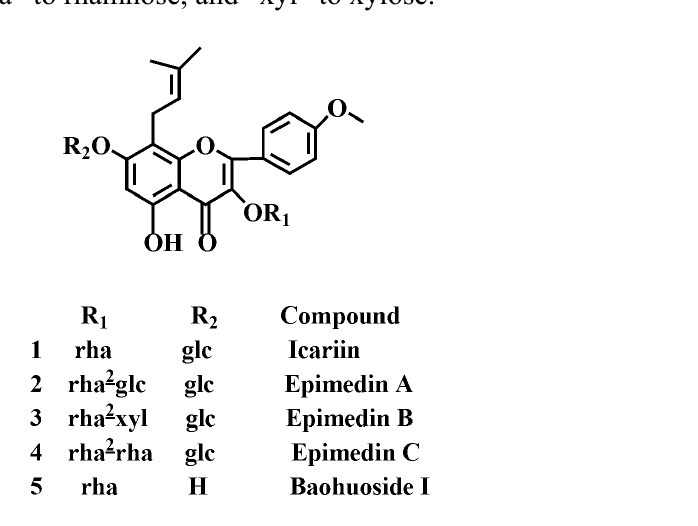
Figure 1. Chemical structures of five prenylated flavonoids in Yinyanghuo. The symbol “glc” refers to glucose, “rha” to rhamnose, and “xyl” to